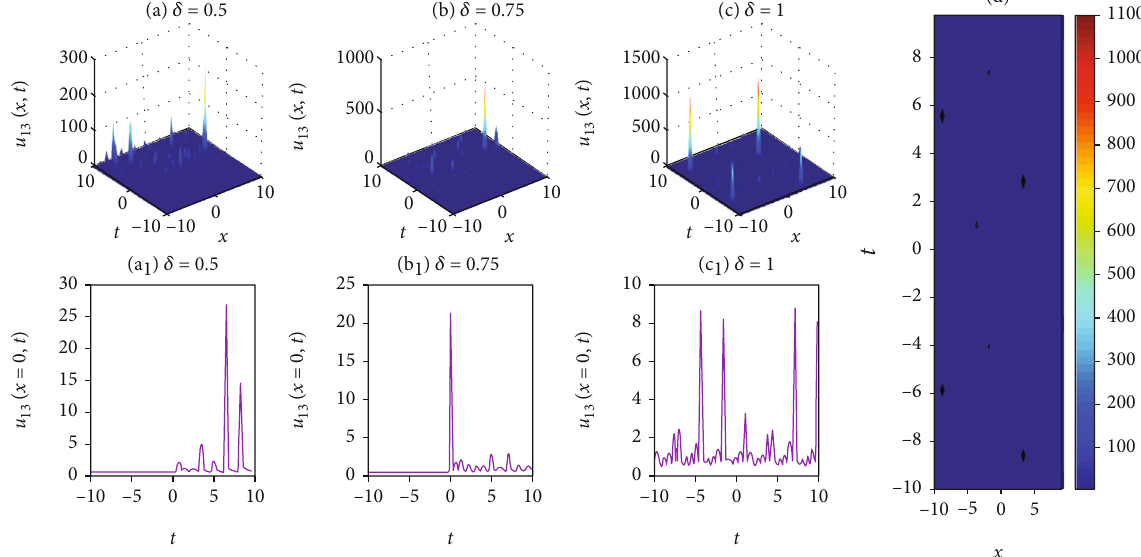
ð x , t Þ . (a – c) 3D plots. (a 13